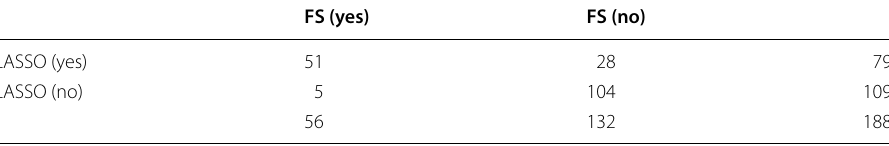
Table 4 Numbers of selected variables of LASSO and significant variables of FS FS (yes) FS (no) LASSO